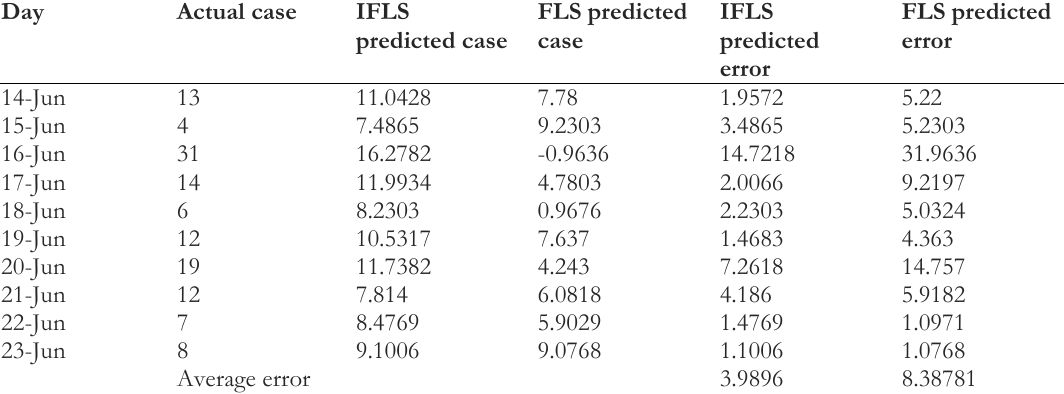
Table 3. Comparison of actual and predicted COVID-19 daily deaths using IFLS and traditional Type-1 FLS.